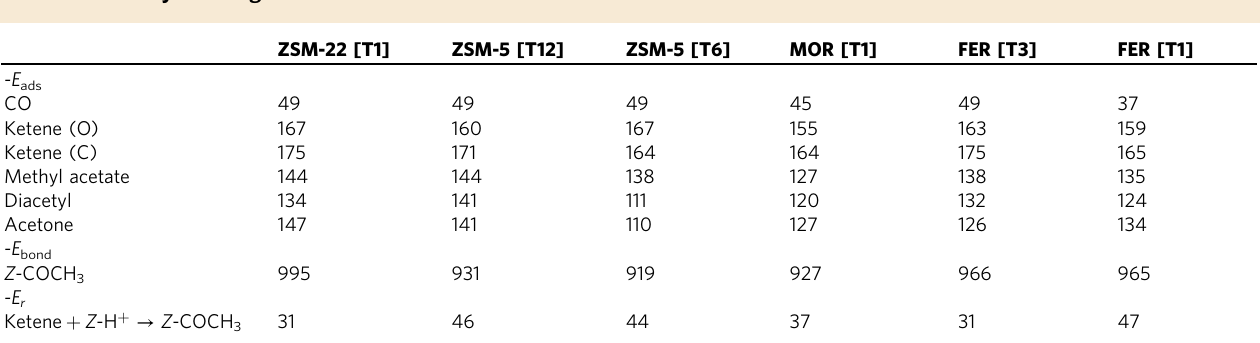
Table 1 Summary of energetic observables.